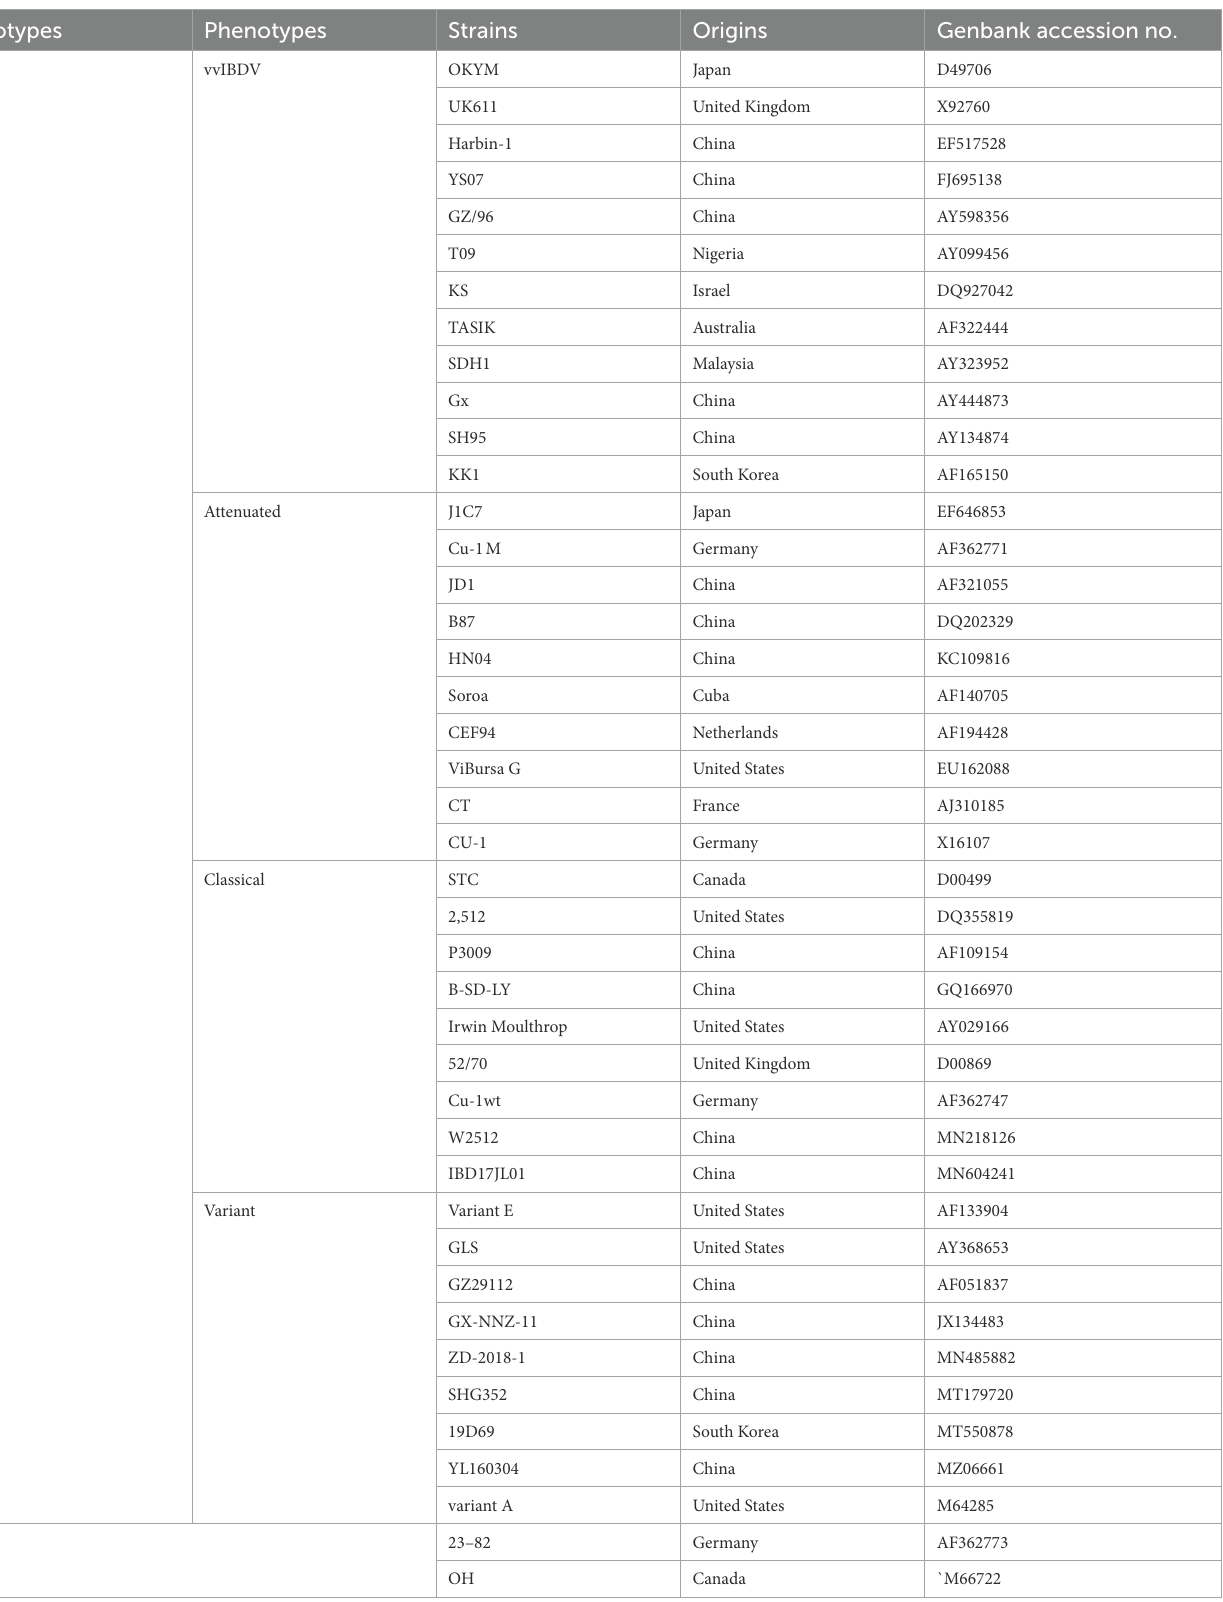
TABLE 1 Reference IBDV strains used in phylogenetic analysis and the sequence alignment.